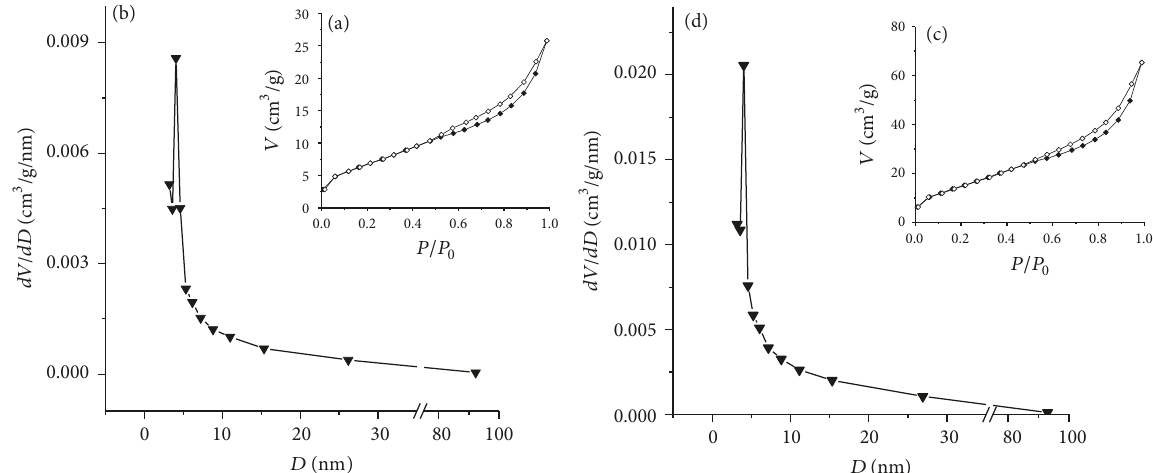
Figure 3: Isotherms of low-temperature nitrogen adsorption-desorption for organobentonite (a) and bentonite (c). BJH pore size distribution for organobentonite (b) and bentonite